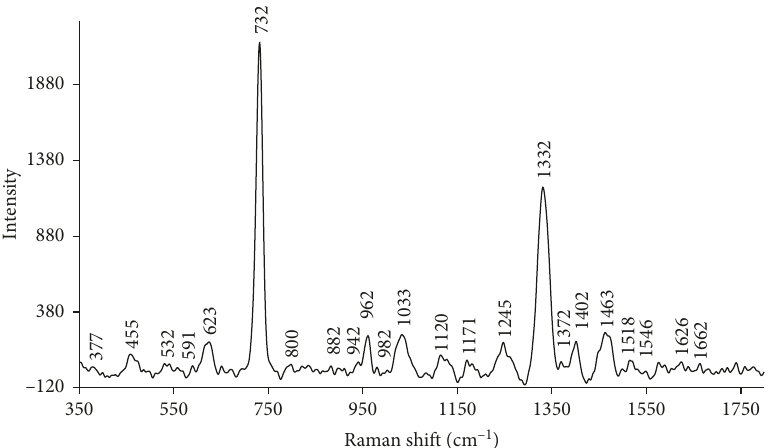
Figure 12: SERS spectrum of aqueous solution of adenine-pyridoxine at pH 7.0 (laser output: 633nm, P Table 3: Experimental Raman and SERS shift values (cm